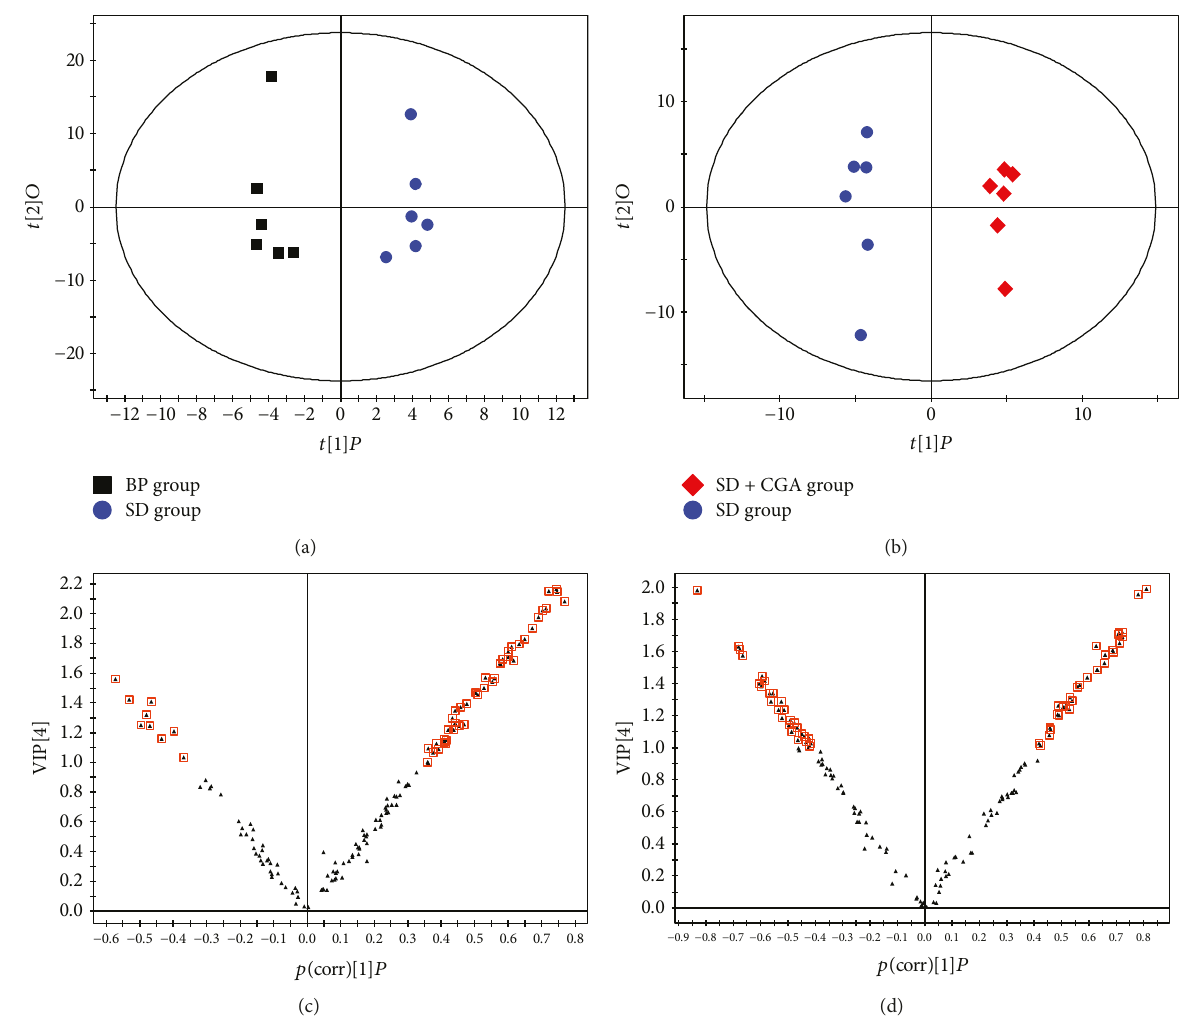
Figure 4: OPLS-DA score plots and V-plots between pairwise